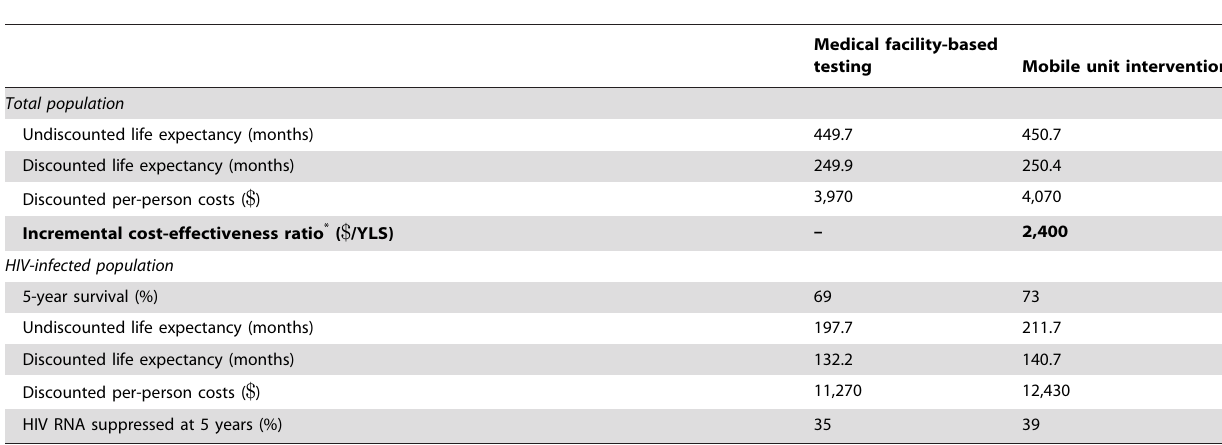
Table 2. Model outcomes and cost-effectiveness of mobile unit HIV testing in Cape Town, South Africa.